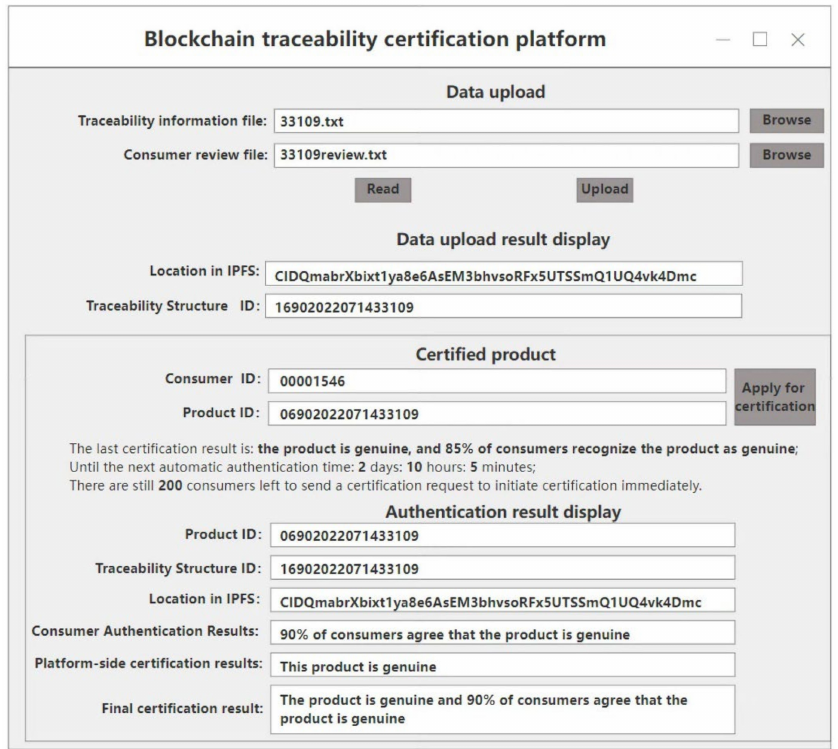
Figure 9. Product certification